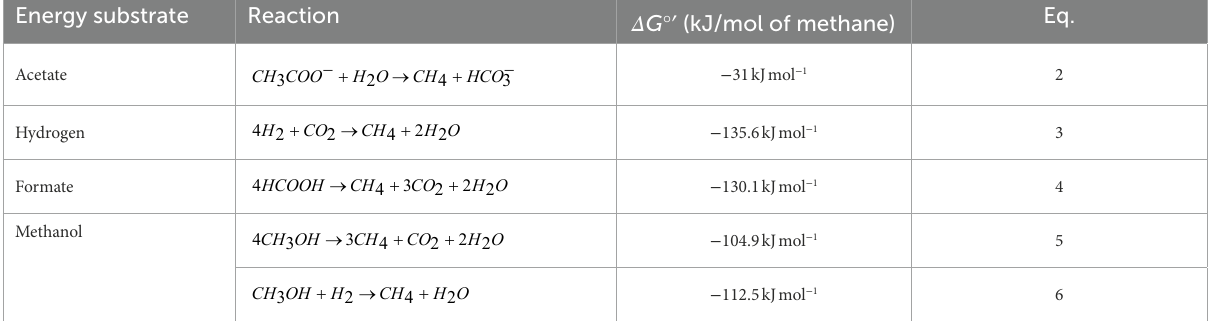
TABLE 3 Reactions and different Gibbs free energy changes for methanogenesis at neutral pH (Dworkin et al., 2006). Energy substrate